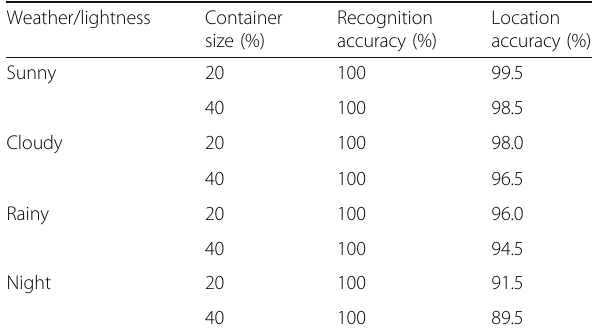
Table 2 Experimental results Weather/lightness